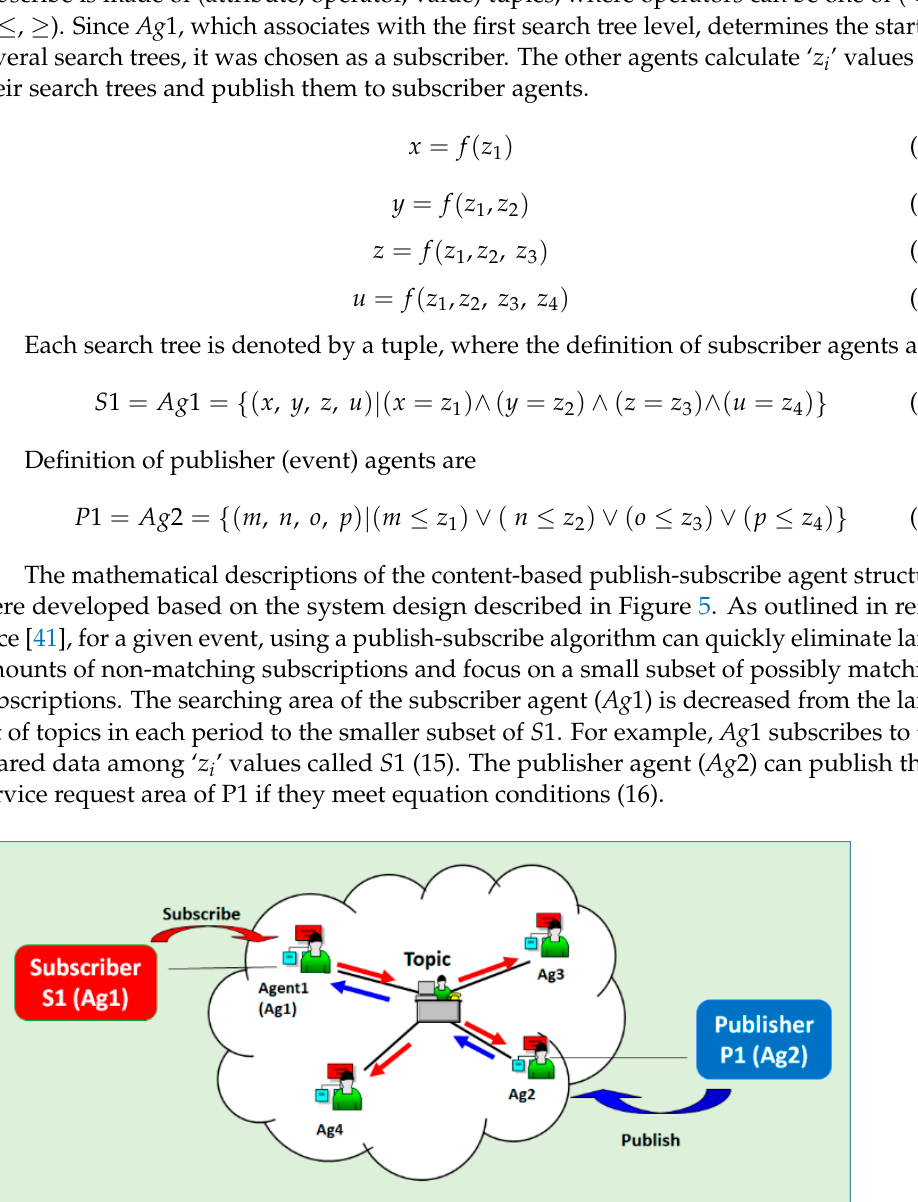
Figure 5. Application of Publish–Subscribe for Finding Global Optimization Ratios.